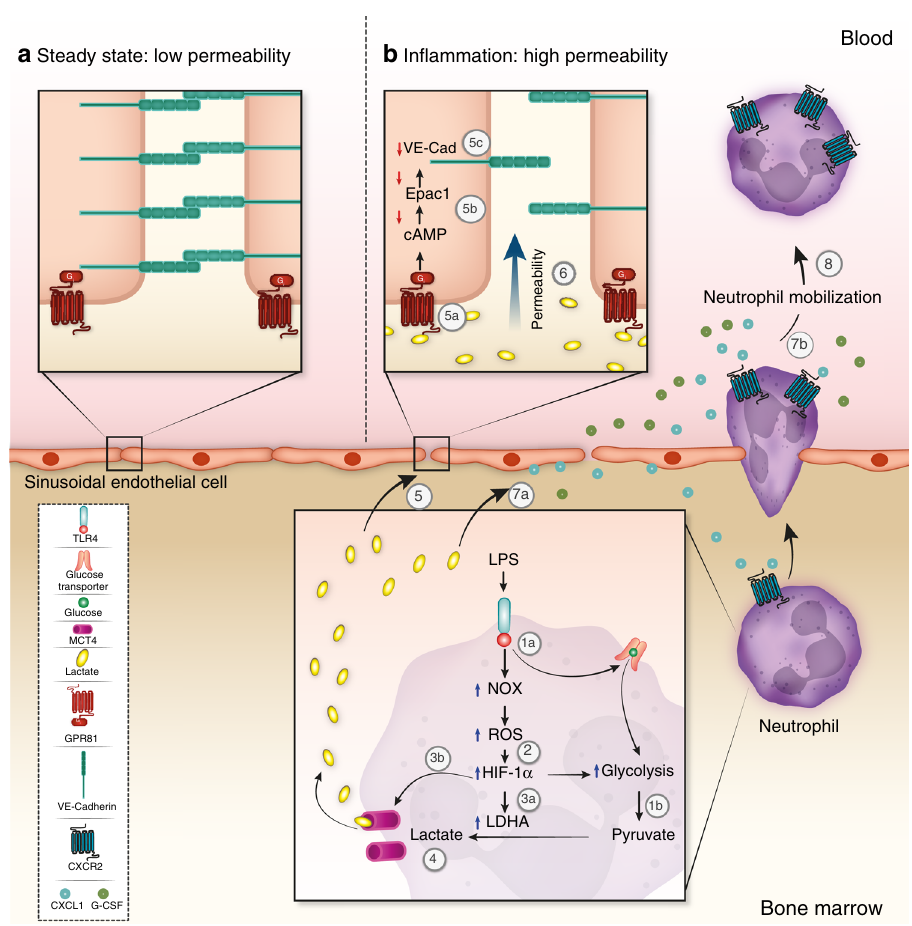
Fig. 8 Mechanisms of lactate-induced neutrophil mobilization from the BM. Our model suggests that enhanced lactate-produced by BM neutrophils during bacterial infection induces neutrophil mobilization by modulating metabolic signaling in BM endothelial cells. LPS binds TLR4 expressed on neutrophils that directly activates NADPH oxidase (NOX) and enhances glucose uptake via a glucose transporter 1a. Glucose in turn, is converted to pyruvate by the glycolysis pathway 1b. NOX activity leads to ROS production (2) which elevates HIF-1 α expression. HIF-1 α in turn, induces downstream expression of LDHA that converts pyruvate to lactate 3a. HIF-1 α also up-regulates the lactate transporter MCT4 3b to allow lactate release (4). Under steady-state conditions, surface VE – cadherin on endothelial cells (ECs) is highly expressed, which maintains the endothelial barrier integrity with low permeability ( a ). During in fl ammation ( b ), lactate released from BM neutrophils binds to GPR81 on sinusoidal BM endothelial cells 5a, activates G i protein and thereby reduces cAMP/Epac1 activity 5b. Consequently, lactate via GPR81 signaling decreases surface VE – cadherin expression (5c), leading to higher BM vascular permeability (6). In addition, lactate elevates CXCL1 and G-CSF levels (produced by different cells including ECs 50,52 ) also in a GPR81- independent manner 7a with more moderate increases in CXCL2 levels in WT mice (most probably produced by BM neutrophils 50 ). Lactate-induced elevation of CXCL1, CXCL2, and G-CSF downregulates surface CXCR2 expression on PB neutrophils 7b facilitating neutrophil mobilization (8). Taken together, LPS-induced lactate promotes rapid neutrophil mobilization from the BM to the blood (8) preferentially via BM GPR81/VE – cadherin-dependent (5 – 6) and also by GPR81-independent (7)